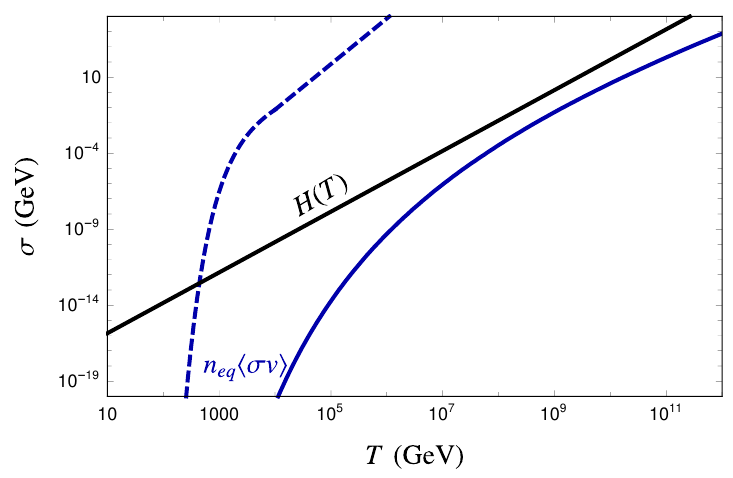
Figure 4 . Dark matter annihilation rate for m χ ( T = 0) = 10 TeV, and α DM ∼ 10 − 2 in the AD model (solid blue line) and without radion dependence (dashed blue line). The AD model param- eters are as in equation (5.3). The Hubble rate assuming radiation domination and g ∗ = 106 . 75 is shown in